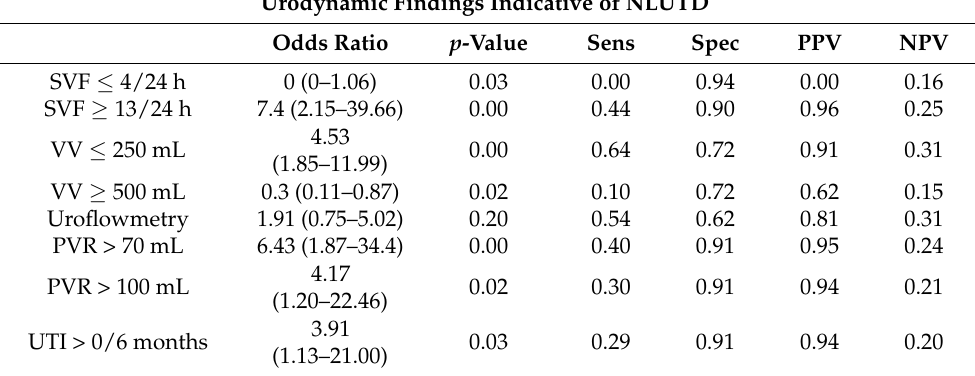
Table 6. Relationship between clinical parameters and UDS indicative of NLUTD and between clinical parameters and reduced